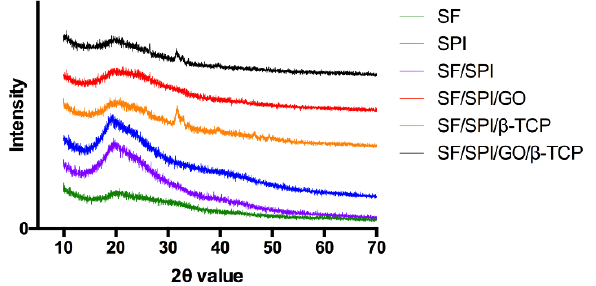
Figure 4. X-ray di ff raction (XRD) patterns of the SF / SPI-based composite sca ff Figure 4. X-ray diffraction (XRD) patterns of the SF/SPI-based composite scaffolds.